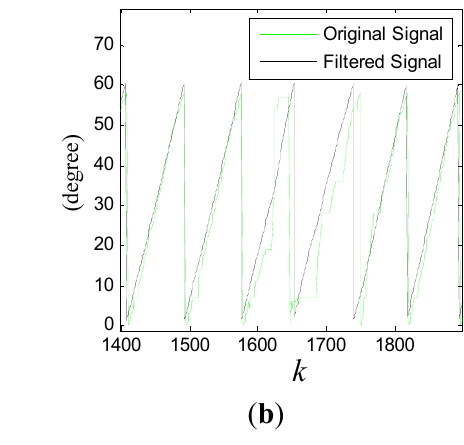
Figure 21. ( a ) Compensated signal ( b ) Final processing result of the phase